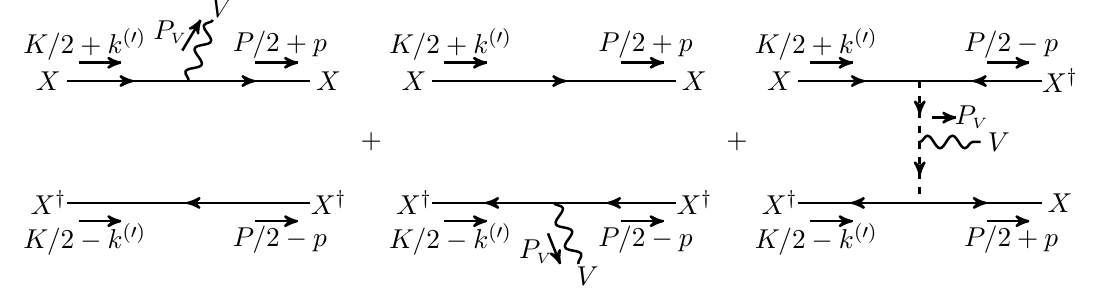
Figure 21 . The leading order contributions to the radiative part of transitions via vector emission XX y ! XX y + V , in the model of eq. (2.1). The arrows on the (cid:12)eld lines denote the (cid:13)ow of the U(1) D